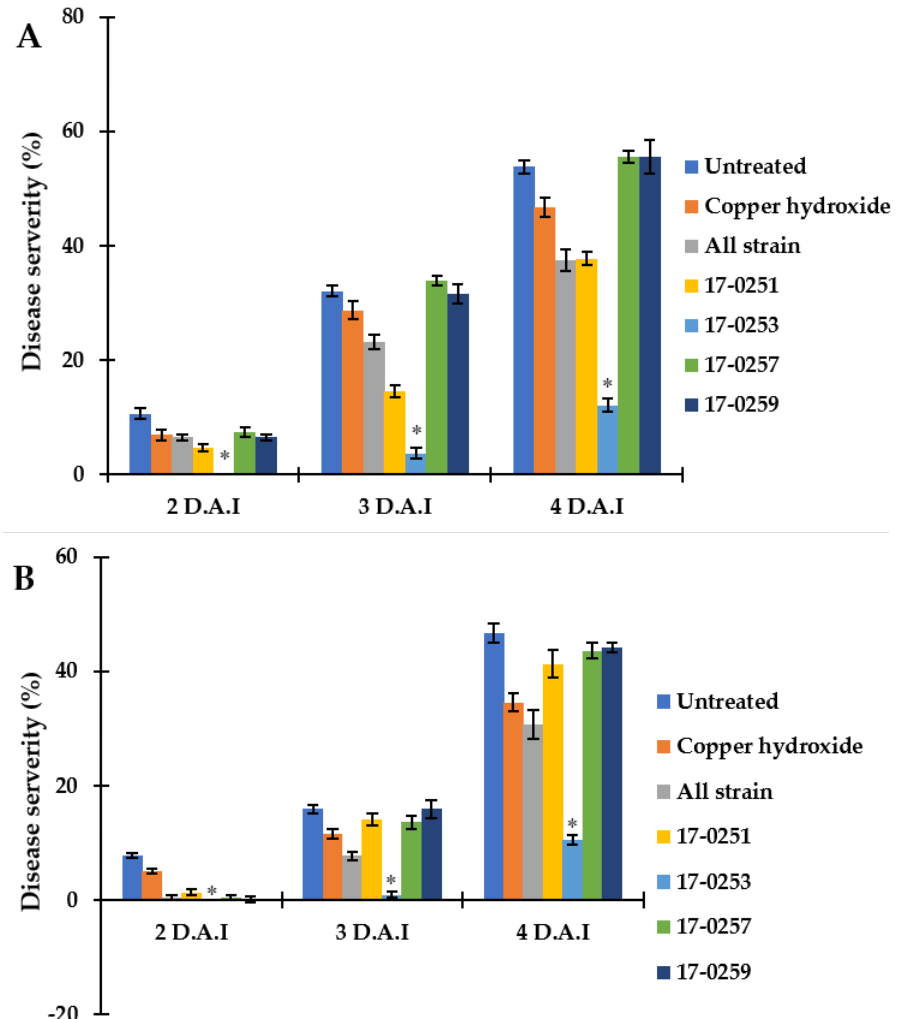
Figure 6. Efficacy of soil treatments with culture of endophytic fungi and copper hydroxide at seedling stage of watermelon and melon caused by Aac , JT-0003 under greenhouse. A histogram showing difference in disease severity percentage of Aac of ( A ) watermelon and ( B ) melon for seven treatments. Values are the means of two experiments, each treatment with three replicates. Vertical bars represent the standard error of means (n = 2). Asterisks represent treatments in which disease severity was significantly (* p < 0.05) reduced compared to control treatment.